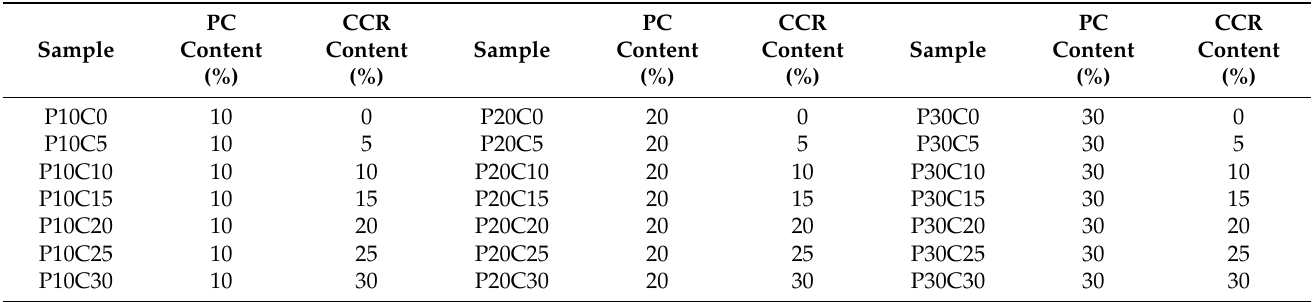
Table 3. Mixture design of the